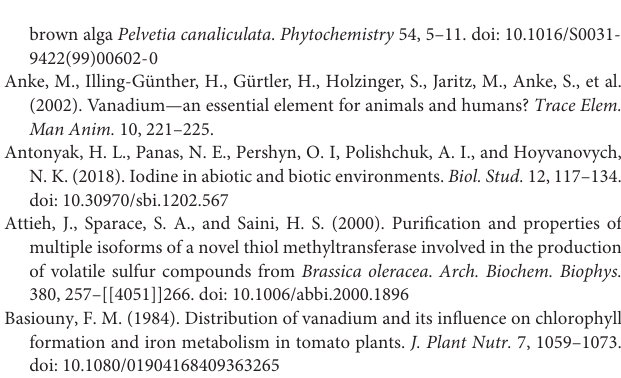
Supplementary Data 4 | The functional annotation of samdmt